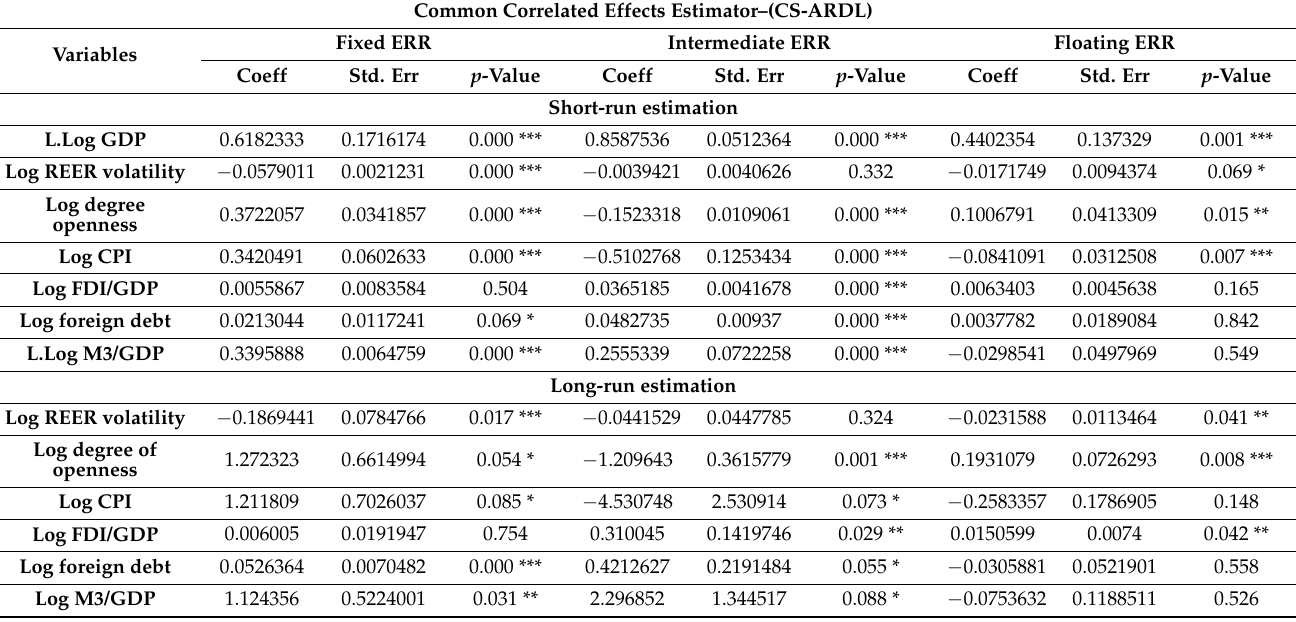
Table 13. Panel CS-ARDL estimation results by exchange rate